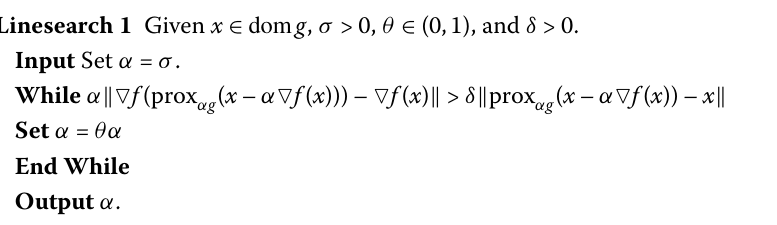
Algorithm 1 Given x 1 ∈ dom g , σ > 0, θ ∈ (0,1), and δ ∈ (0, 1